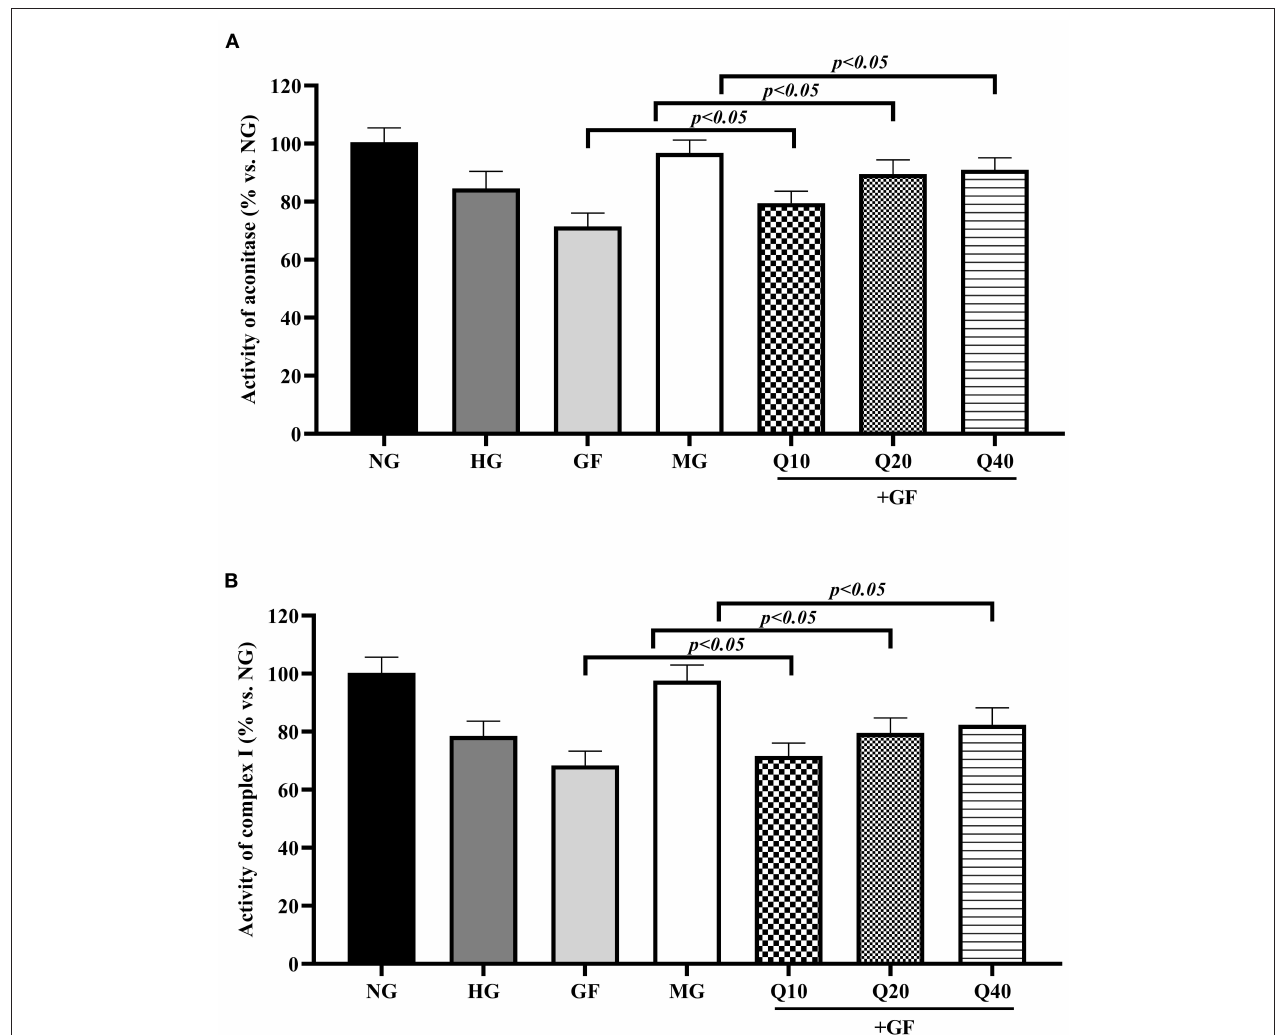
FIGURE 3 | Quercetin increased activities of FeS-dependent metabolic enzymes in condition of GF. The activities of two typical FeS-dependent metabolic enzymes, aconitase (A) , and complex I (B) , were measured with colorimetric assays. The error bar reflects the S.E.M. of at least three independent experiments.